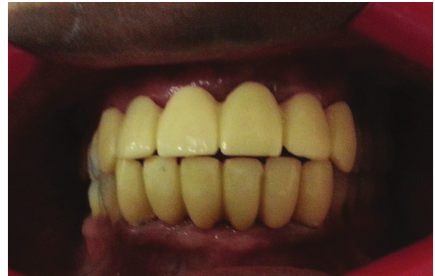
Figure 3: Refined and finalized provisional